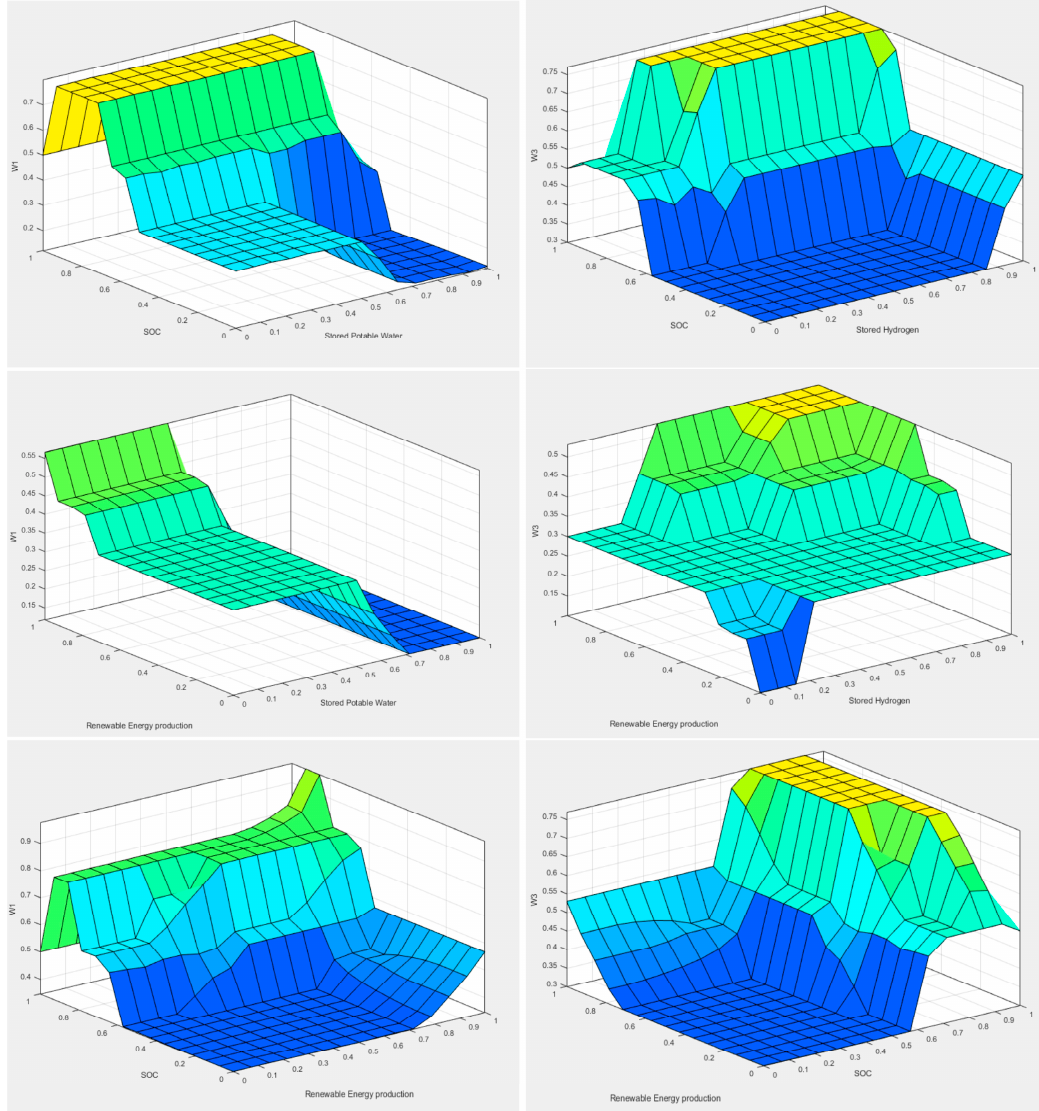
Figure 6. Surfaces of the Fuzzy Logic system.